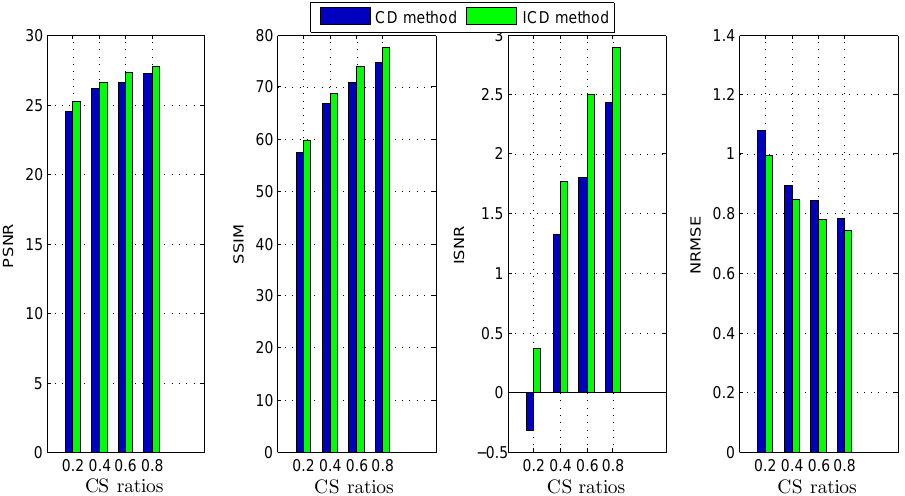
Figure 6. Deconvolution quality assessment for group2 .